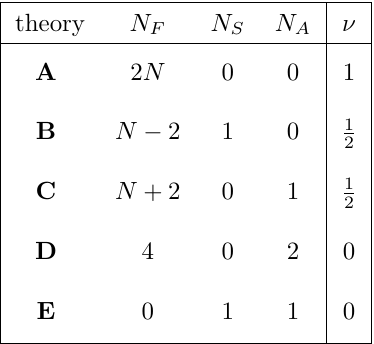
Table 1 . The (cid:12)ve families of = 2 superconformal theories with SU( N ) gauge group and matter N in fundamental, symmetric and anti-symmetric representations. These theories have been identi(cid:12)ed long ago in [55], and more recently they have been considered in [23,